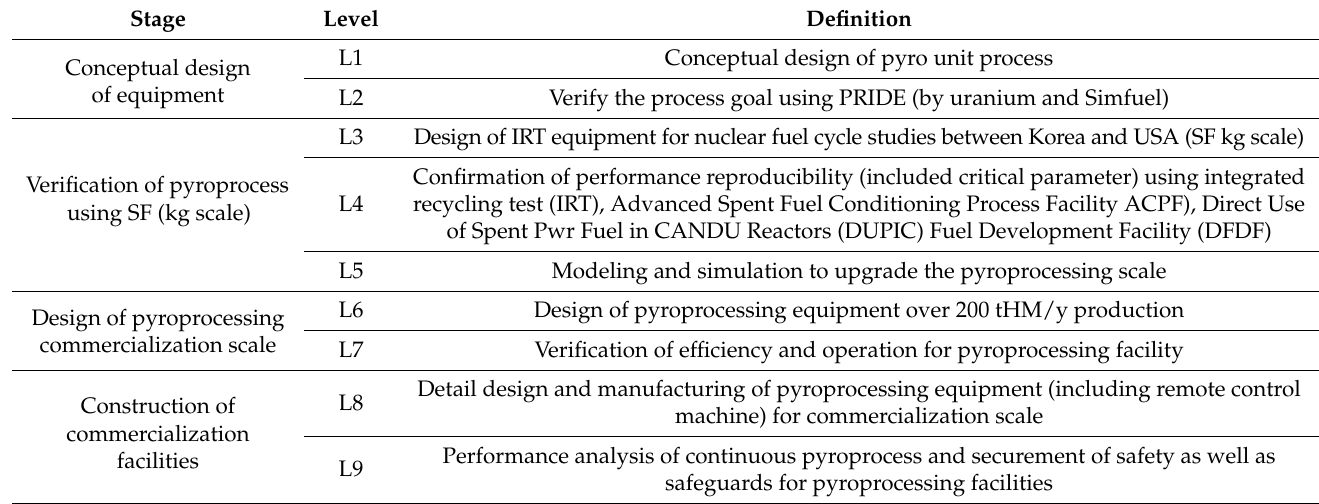
Table 3. Definition for technology readiness levels